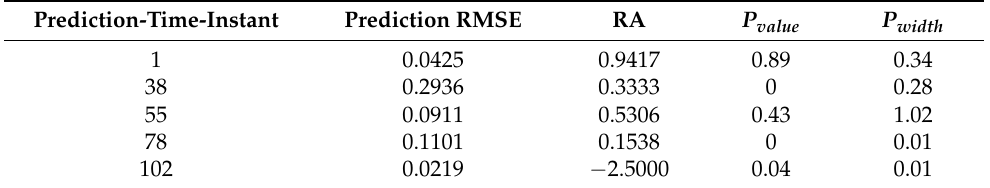
Table 14. The RMSE, RA, P value and P width of 5 time-instant of interest on tests 4 (B0018 and exponen- tial equation).